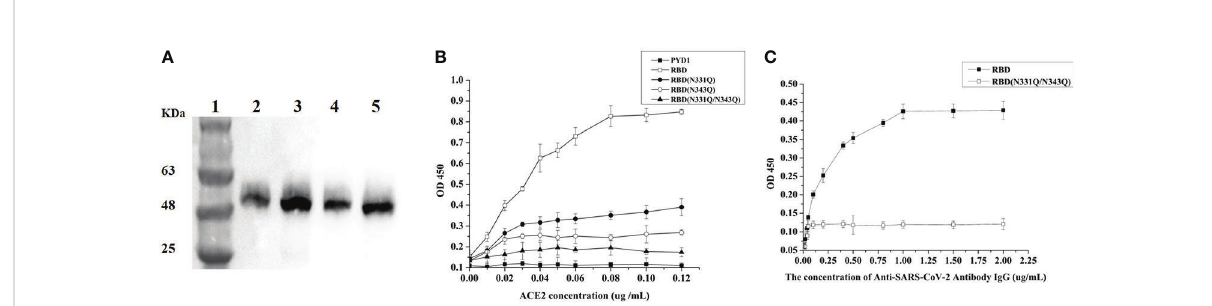
FIGURE 7 Glycosylation analysis of N331 and N343 of RBD. (A) Western blotting analysis of RBD protein and its mutant variants expressed on the surface of S . cerevisiae EBY200; lane 1: Mark, lane 2: PYD1-RBD/EBY200, lane 3: PYD1-RBD (N331Q)/EBY200, lane 4: PYD1-RBD (N343Q)/EBY200, lane 5: PYD1-RBD (N331Q&N343Q)/EBY200. (B) Binding of SARS-CoV-2 Spike protein RBD and its deglycosylation mutant variants to human ACE2. (C) Neutralizing activity of RBD and RBD (N331Q/N343Q) with SARS-CoV-2 IgG.